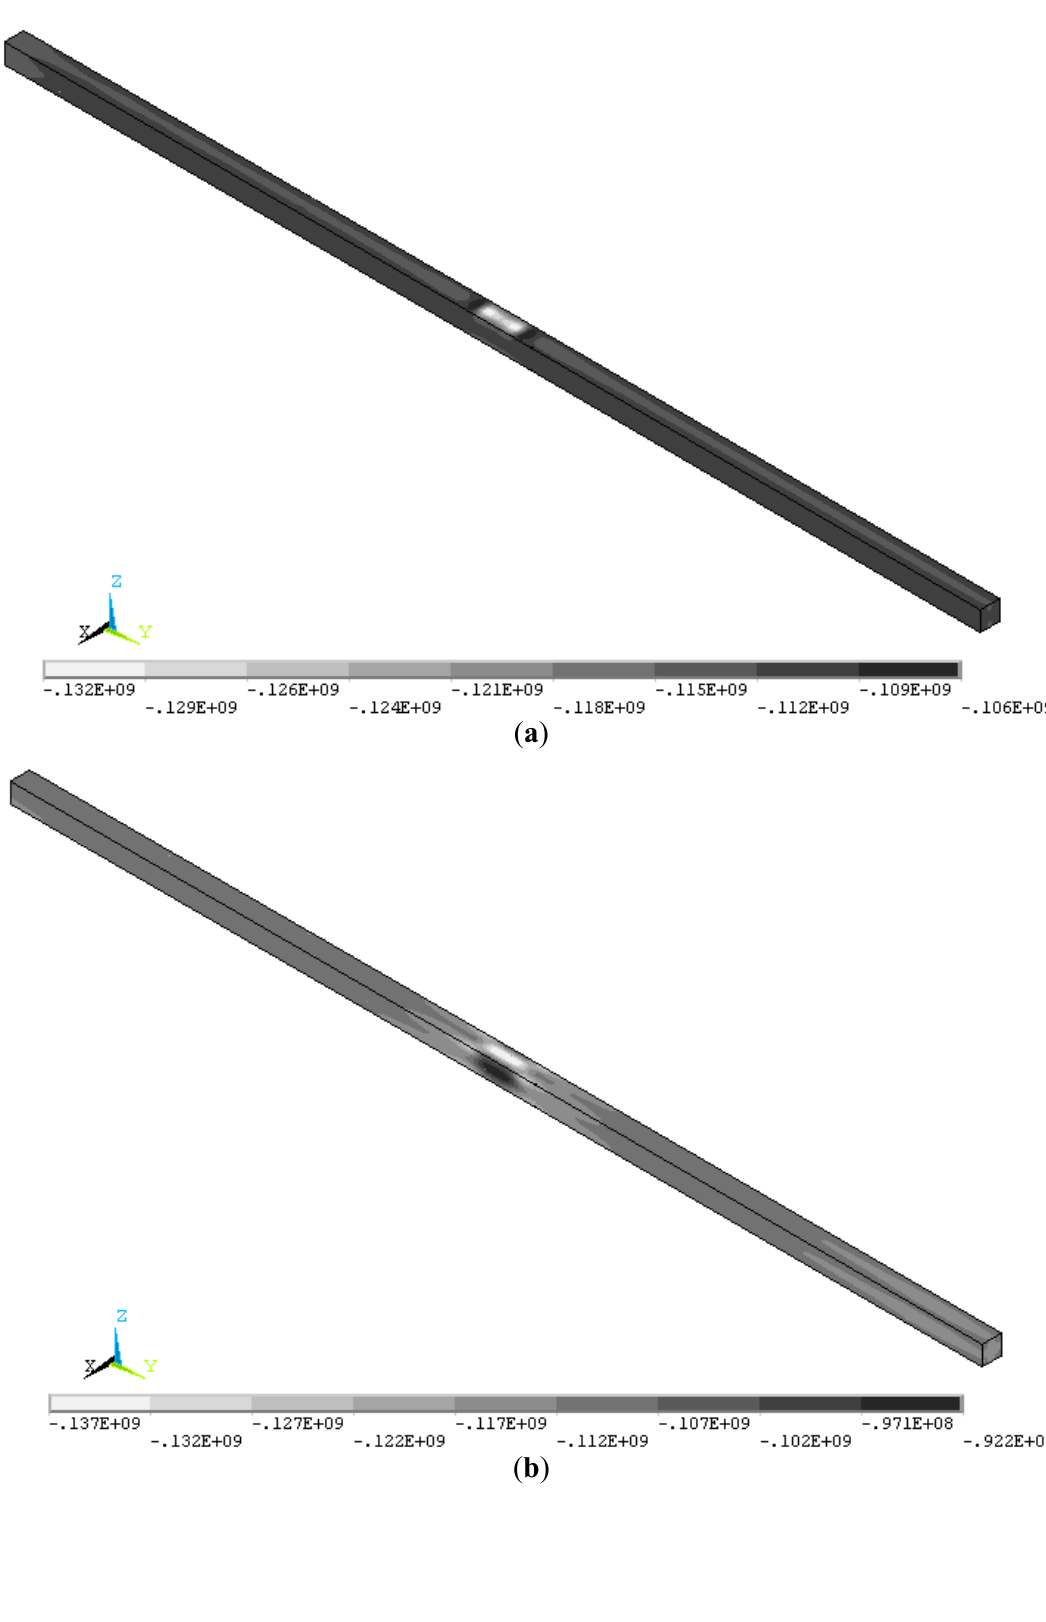
Figure 6. Stress distribution at t = 1 s: ( a ) x direction; ( b ) y direction; and ( c ) z